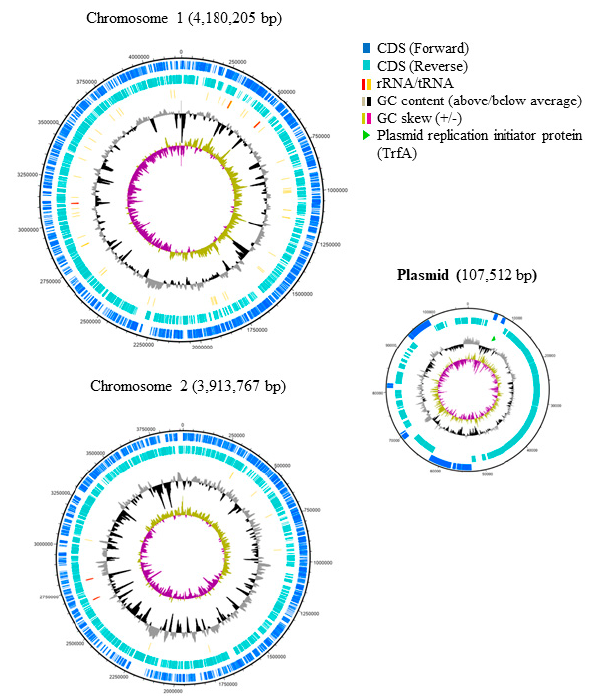
Figure 2. Genome maps of B. gladioli BBB-01. The nucleotide sequence of the genome was determined as described in Section 4. The genetic features were labeled from the outer to the inner rings of the maps. The 1st and 2nd rings indicate the protein-coding sequences (CDS) encoded in the forward and reverse strands of genome, respectively. The 3rd ring indicates the genes of rRNA and tRNA with red and yellow sticks, respectively. The 4th ring indicates GC content. Those being above and below the average are shown by grey and black curves, respectively. The 5th ring indicates GC skew. The positive and negative skew are shown by the light gold and purple curves, respectively. The light green arrowhead in the plasmid map indicates the replication initiator